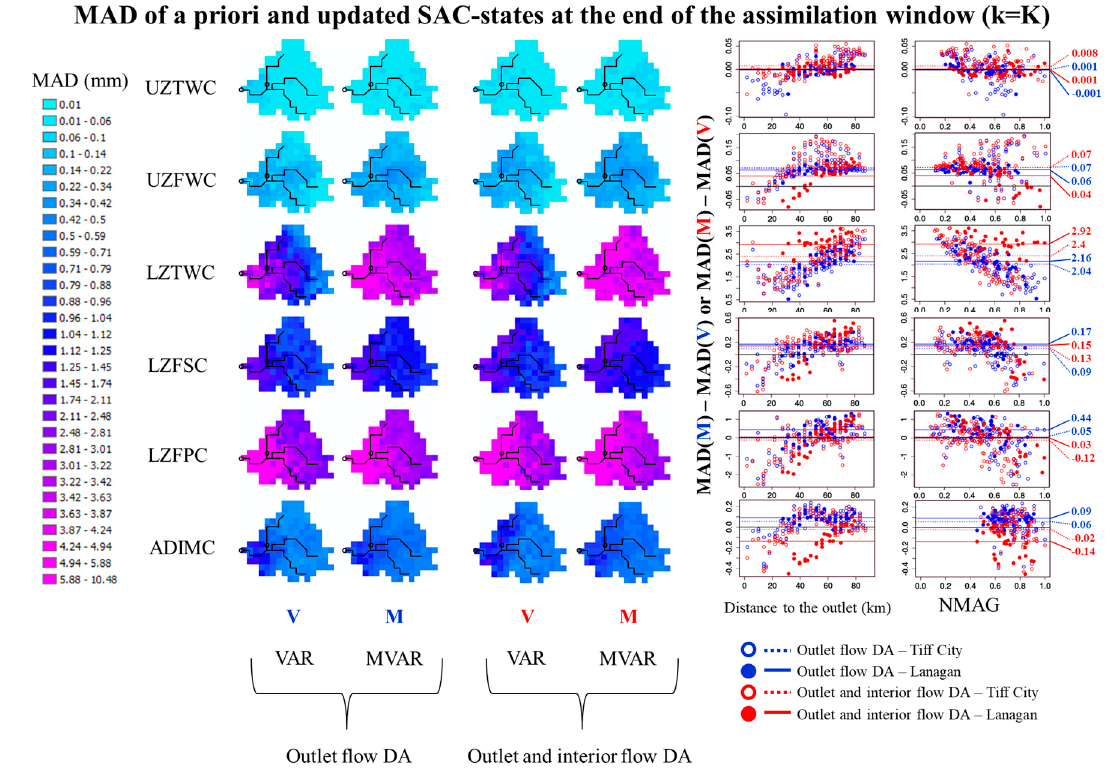
Figure 5. Mean absolute di ff erence (MAD) of a priori and updated SAC-states at the begging ( k = K − L ; top panel) or end ( k = K ; bottom panel) of the assimilation window where the model is applied as a strong-constraint to the assimilation problem.